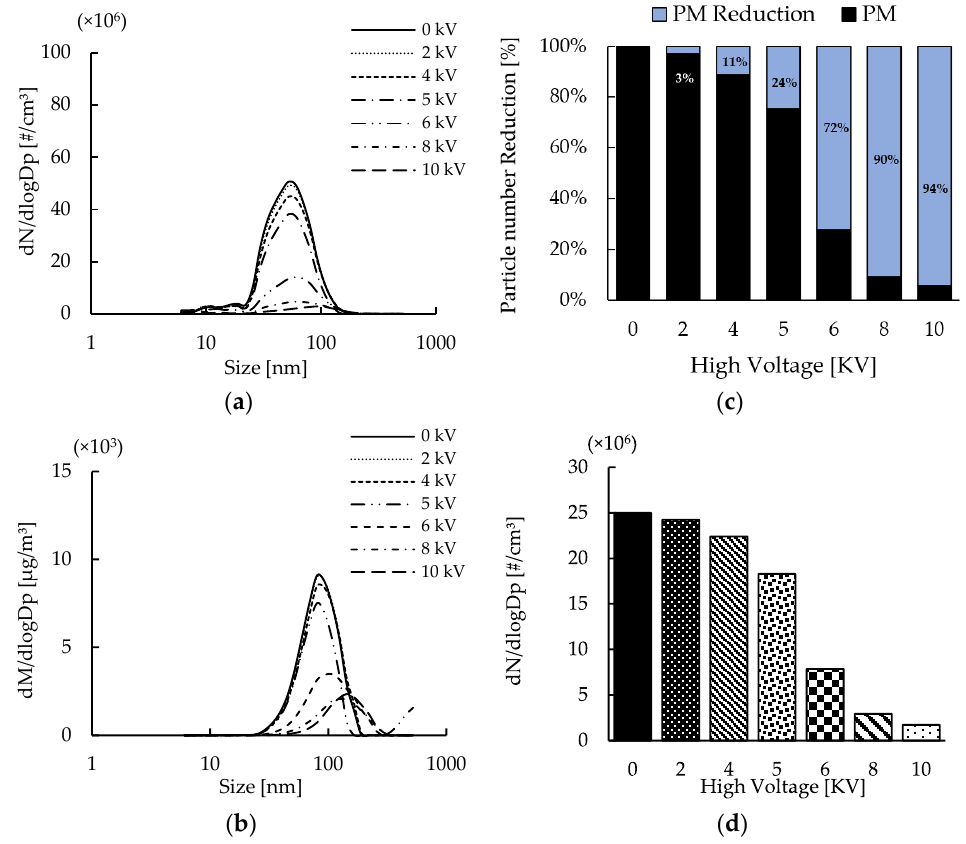
Figure 9. Average number-mass size distributions of PM using the combination of porous material 4 mm and NTP ( a ) Particle number size distributions; ( b ) Particle Mass size distributions. The reduction of PM with the combination of porous material 4 mm and NTP when ( c ) percentage and ( d ) Particle Number.